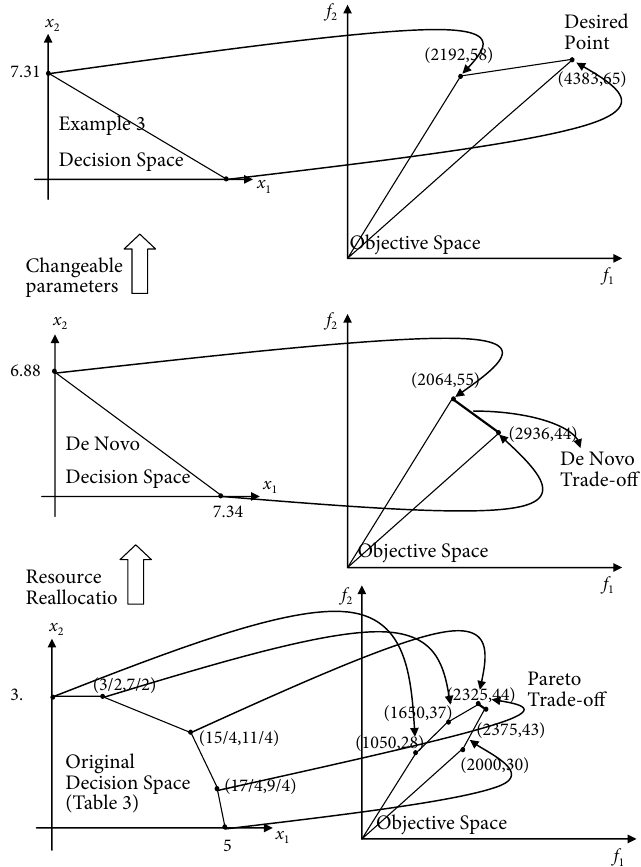
Fig. 3. Changeable spaces for achieving the desired